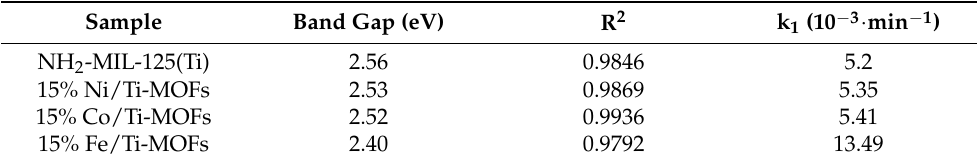
Figure 5. UV-Vis DRS ( A ) and Tauc plot ( B ) of NH 2 -MIL-125(Ti) and 15% M/Ti-MOFs (M: Ni, Co, Fe). Table 2. Band gap energy and kinetic parameters for the degradation RhB over different catalysts.